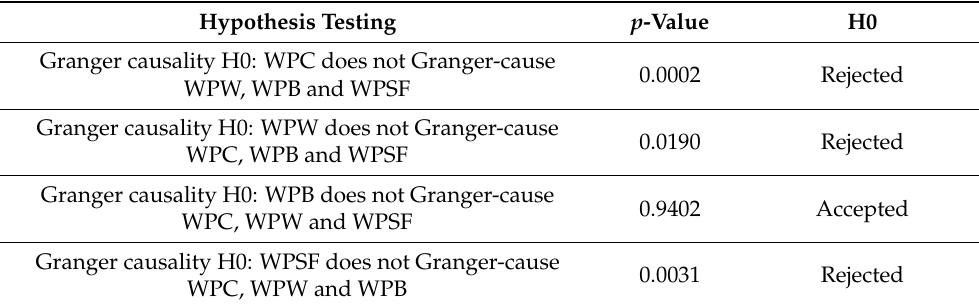
Table 3. Granger causality results based on differenced